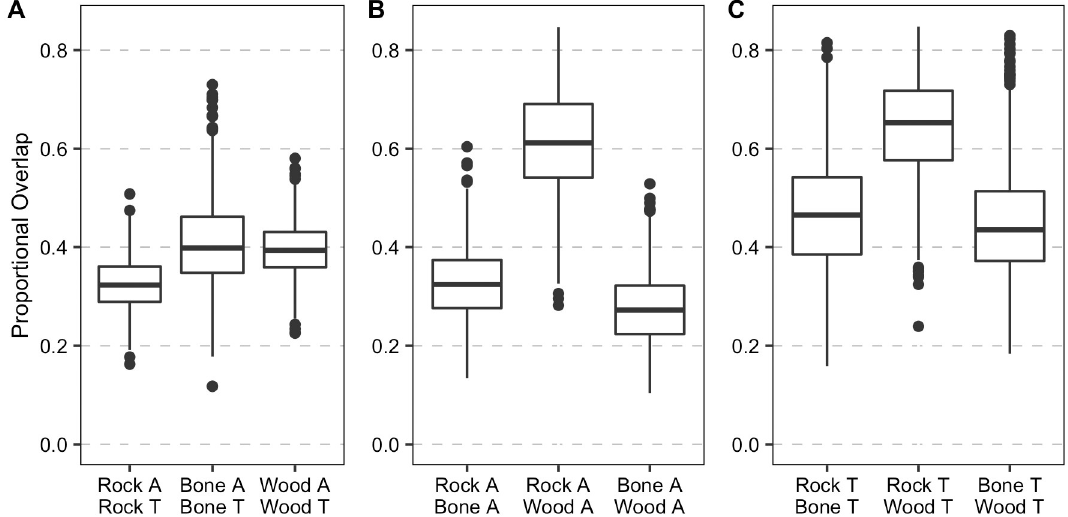
Fig 9. Trophic niche overlap of macrofaunal colonizers on the experimental substrates. Proportional overlap between carbon and nitrogen isotopic niche areas of macrofaunal invertebrates on experimental carbonate rocks (from Pereira et al. [13]), bone and wood deployed at Mound 12 at active and transition sites for 7.4 years (2010–2017). (A) Comparisons between seepage activity within substrate, (B) Comparisons among substrates at active sites, (C) Comparisons among substrates at transition sites. A: Active site, T: Transition site. Boxplots visualize five summary statistics: the median, two hinges (the 25 th and 75 th percentiles), and two whiskers (extend from the hinge to the largest/smallest value at 1.5x the inter-quartile range), as well as outlying points individually.